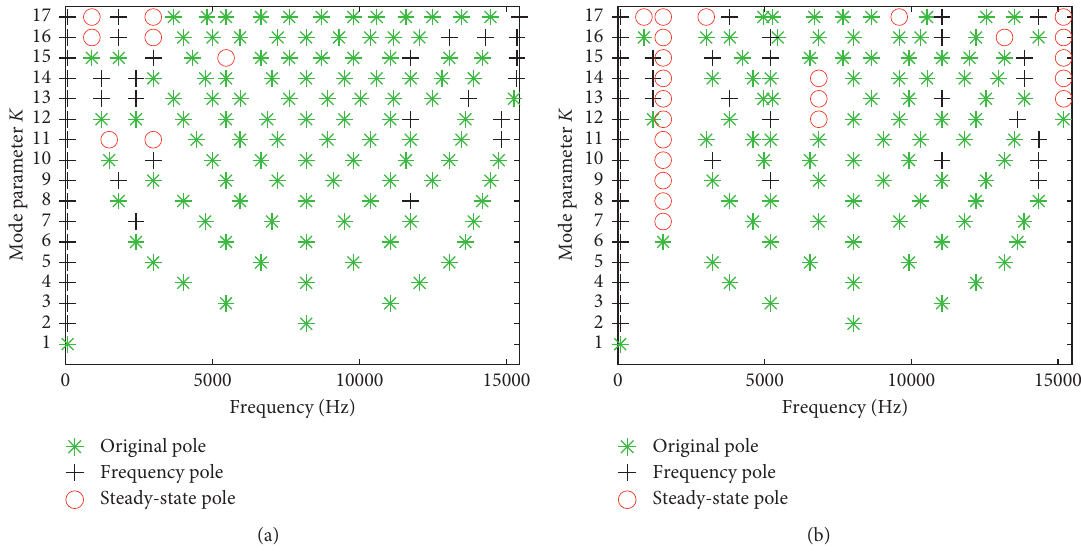
Figure 16: 750 RPM diesel engine steady-state poles diagram. (a) Test point 1. (b) Test point 2.